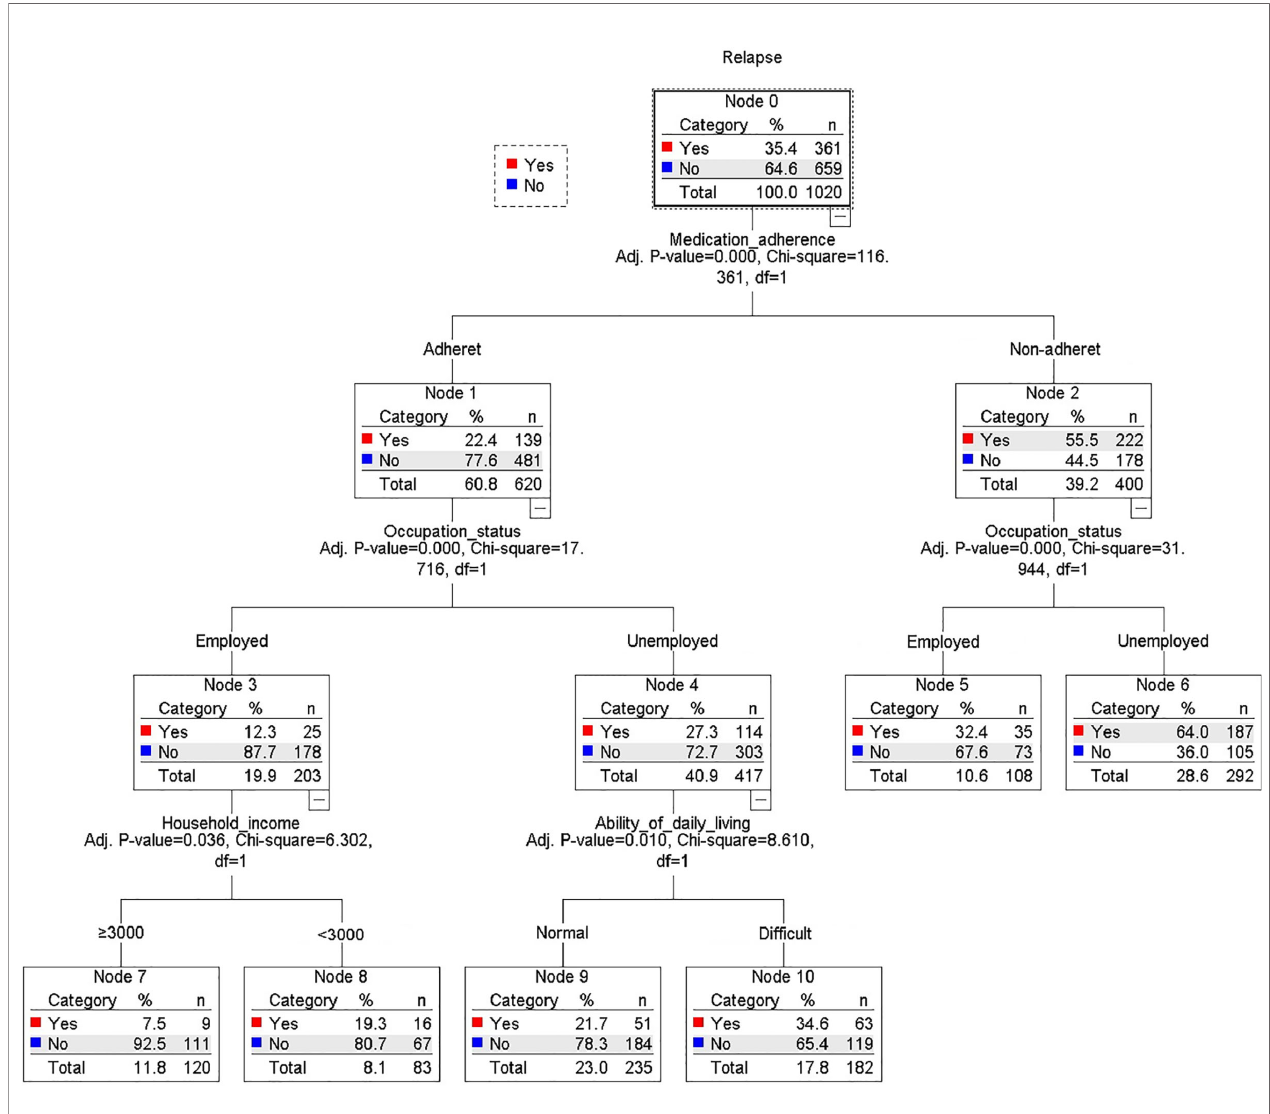
FIGURE 2 | Decision-tree model of predictors of relapse (training model, n = 1,020).